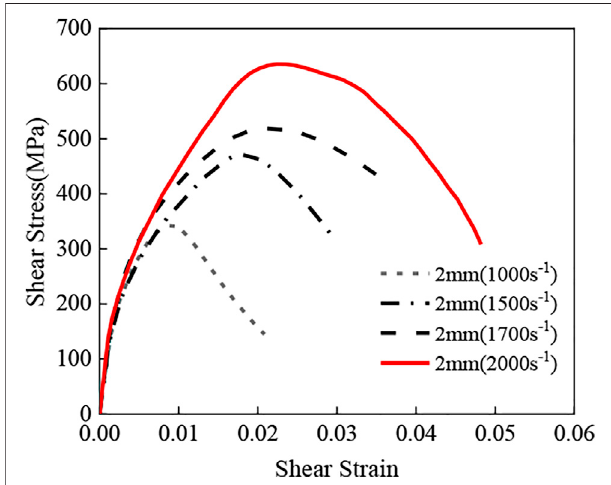
FIGURE 7 | Dynamic shear stress – strain curves of specimens with 2 mm welding length.